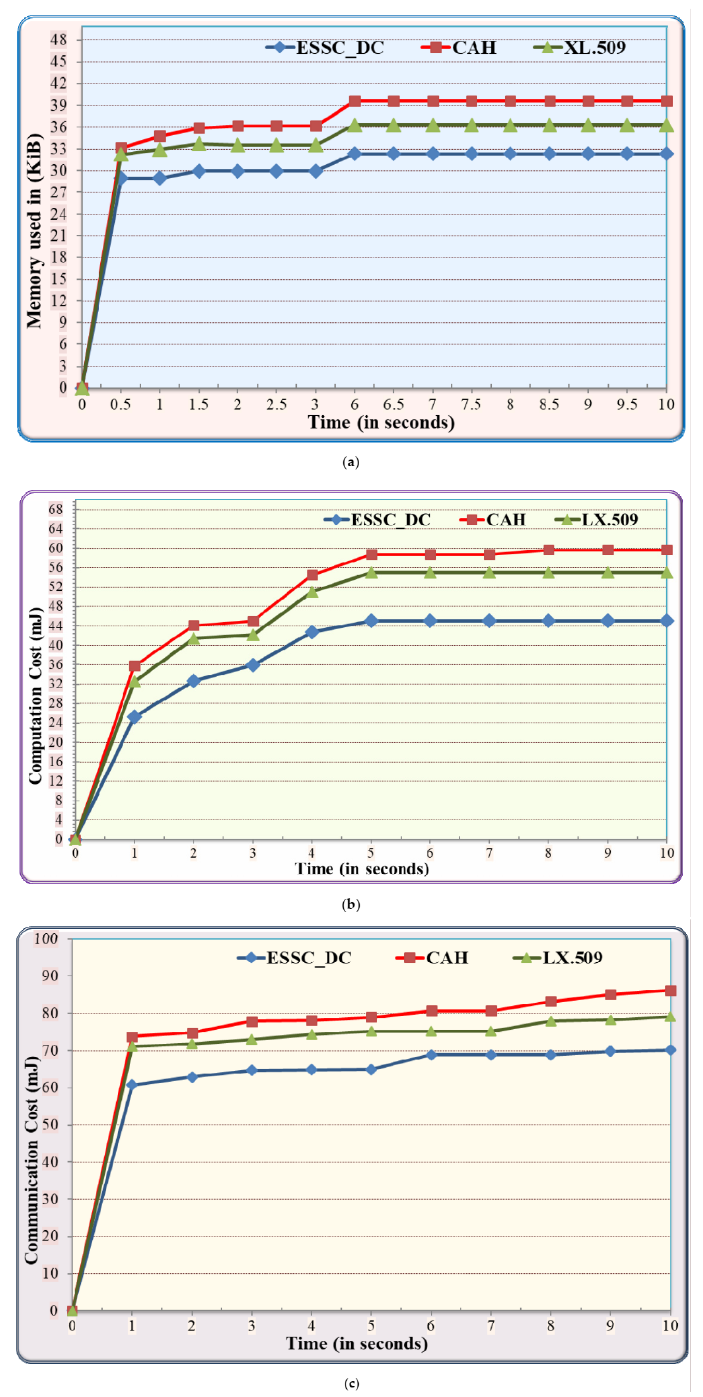
Figure 6. Performance comparison between ESSC digital certificate and baseline algorithms on IIoT ( a ) Execution Time; ( b ) Function Calls; ( c ) Energy